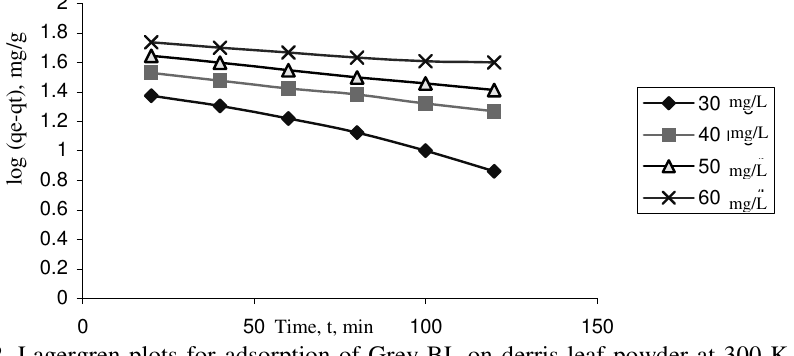
Figure 2. Lagergren plots for adsorption of Grey BL on derris leaf powder at 300 K (dye concentration 50